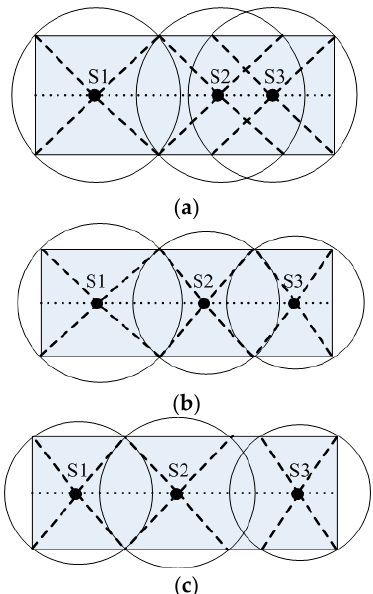
Figure 5. Selection of wireless ranges by three sinks in the network: ( a ) extremely large; ( b ) suitable; and ( c ) extremely small.